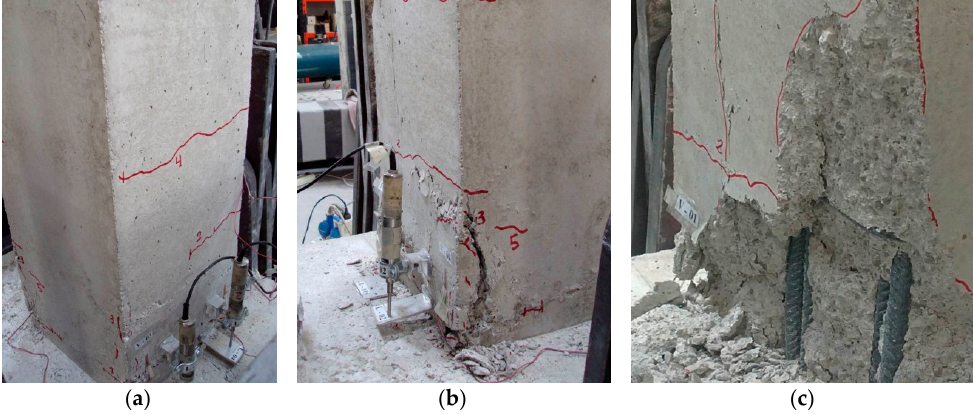
Figure 14. Crack pattern: control specimen C1N.